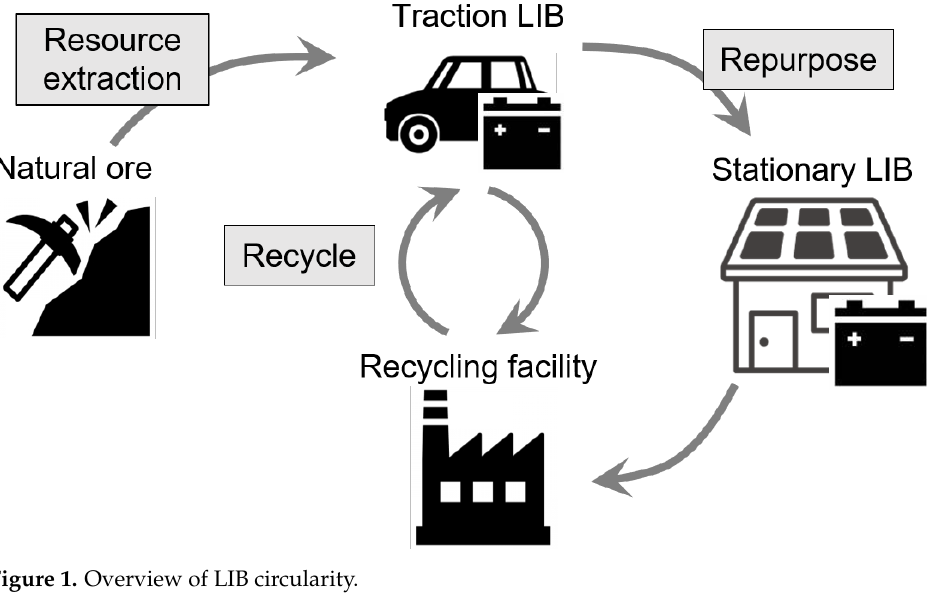
Figure 1. Overview of LIB circularity.